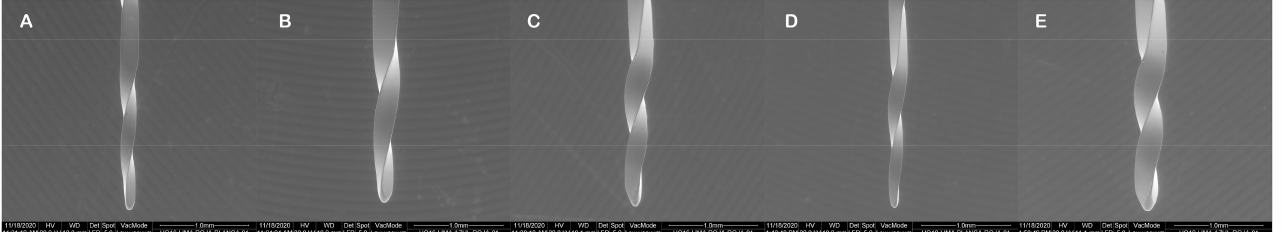
Figure 1. Scanning electron microscopy (SEM) analysis of the taper of ( A ) 25.02, ( B ) 25.04, ( C ) 25.06, ( D ) 20.06, and ( E ) 30.06 NiTi endodontic rotary